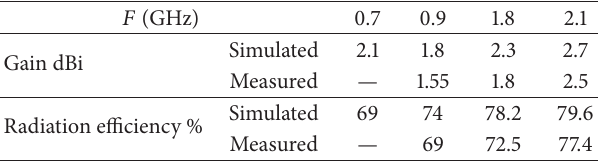
Figure 4: The effect of ground plane length against frequency. Table 2: Gain and the radiation efficiency of the proposed antenna.